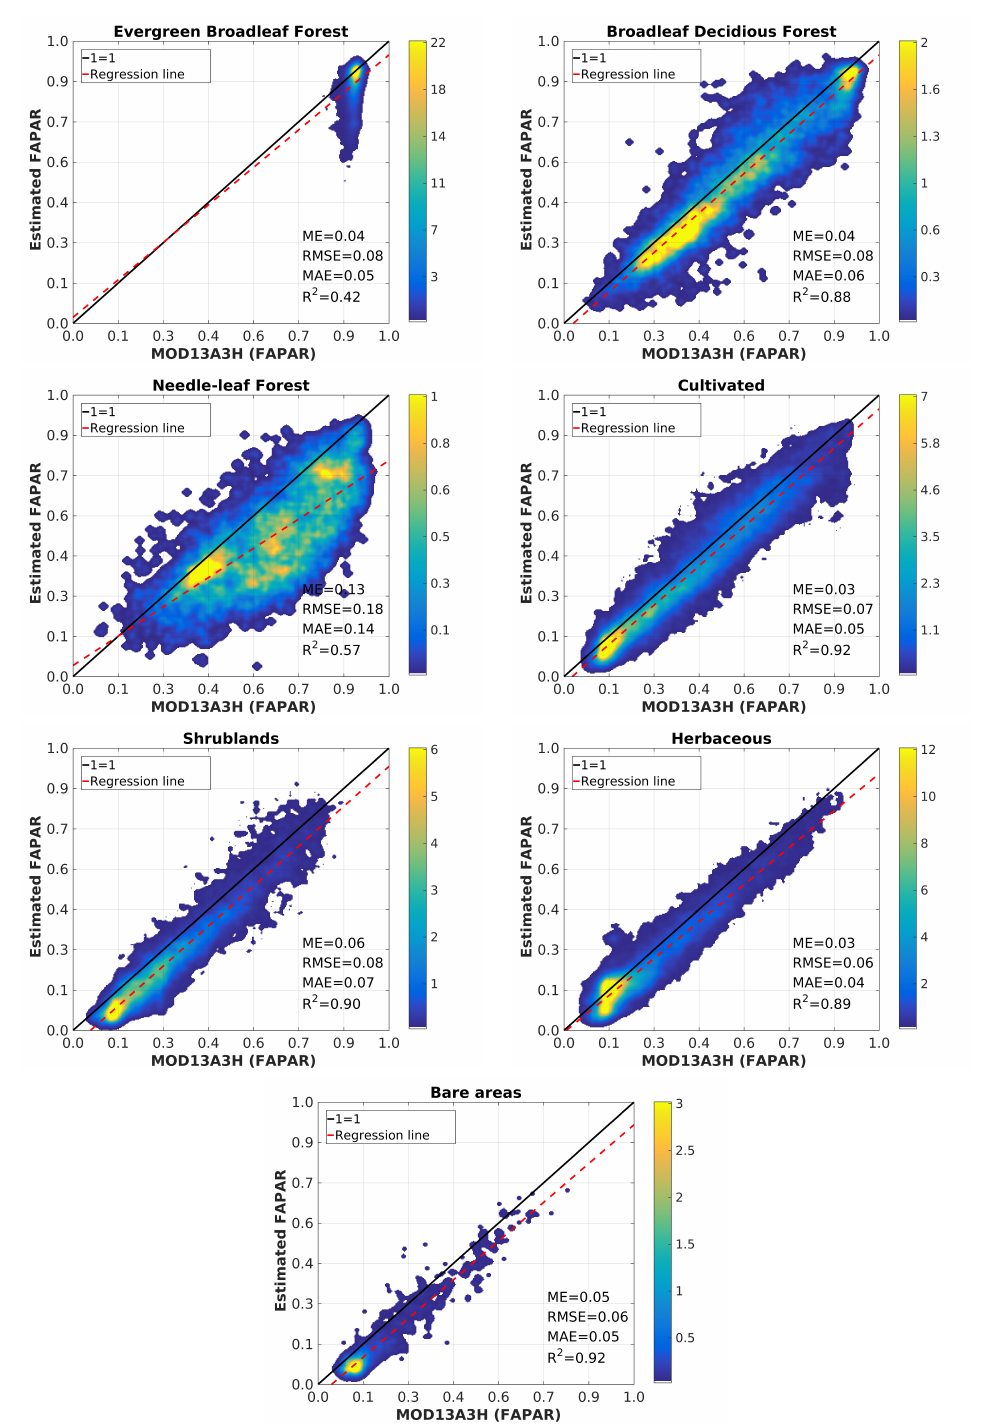
Figure 8. Biome-dependent scatter plots of the retrieved FAPAR over BELMANIP2.1 sites for the period 2002–2017. The colorbar indicates density of points in the scatter